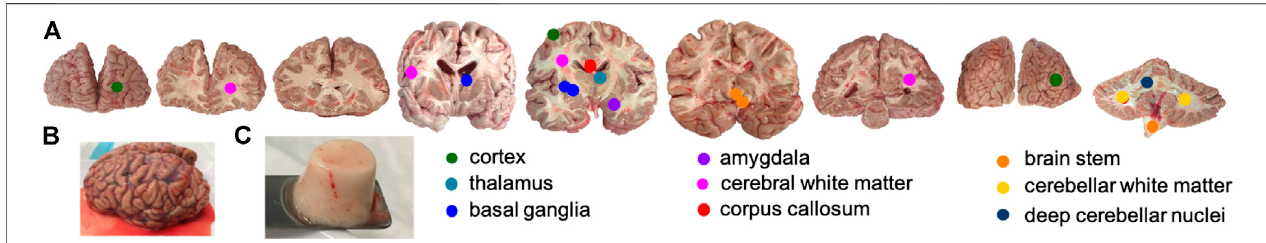
FIGURE 1 | Human brain tissue samples. (A) Locations where (C) specimens were harvested from (B) complete brains. Circles marking the location of specimen extraction were enlarged for better visibility.